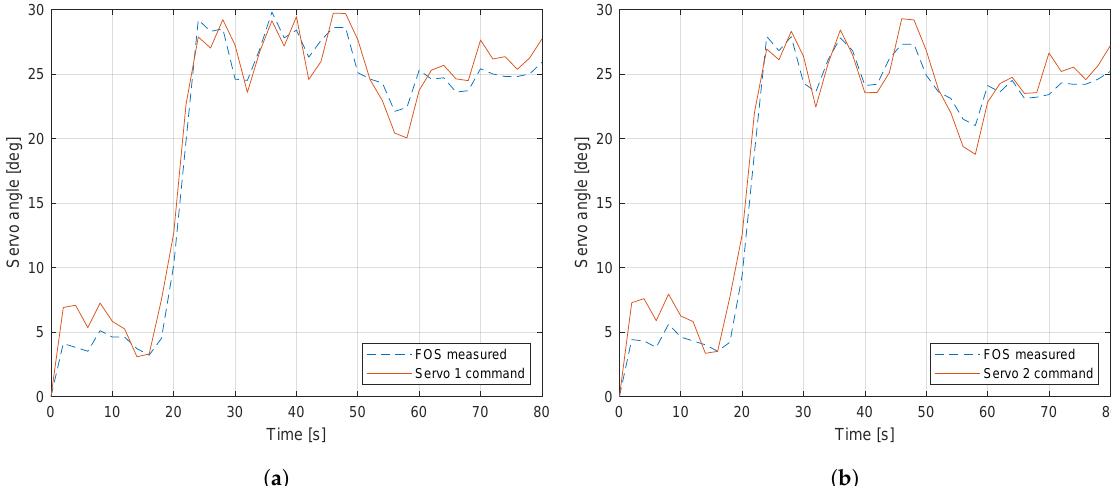
Figure 12. Estimated position with respect to module #1 deflections for the F y = 30 and M x = 0 case. The positions of actuators 1 and 2 are separated and shown in ( a , b ),